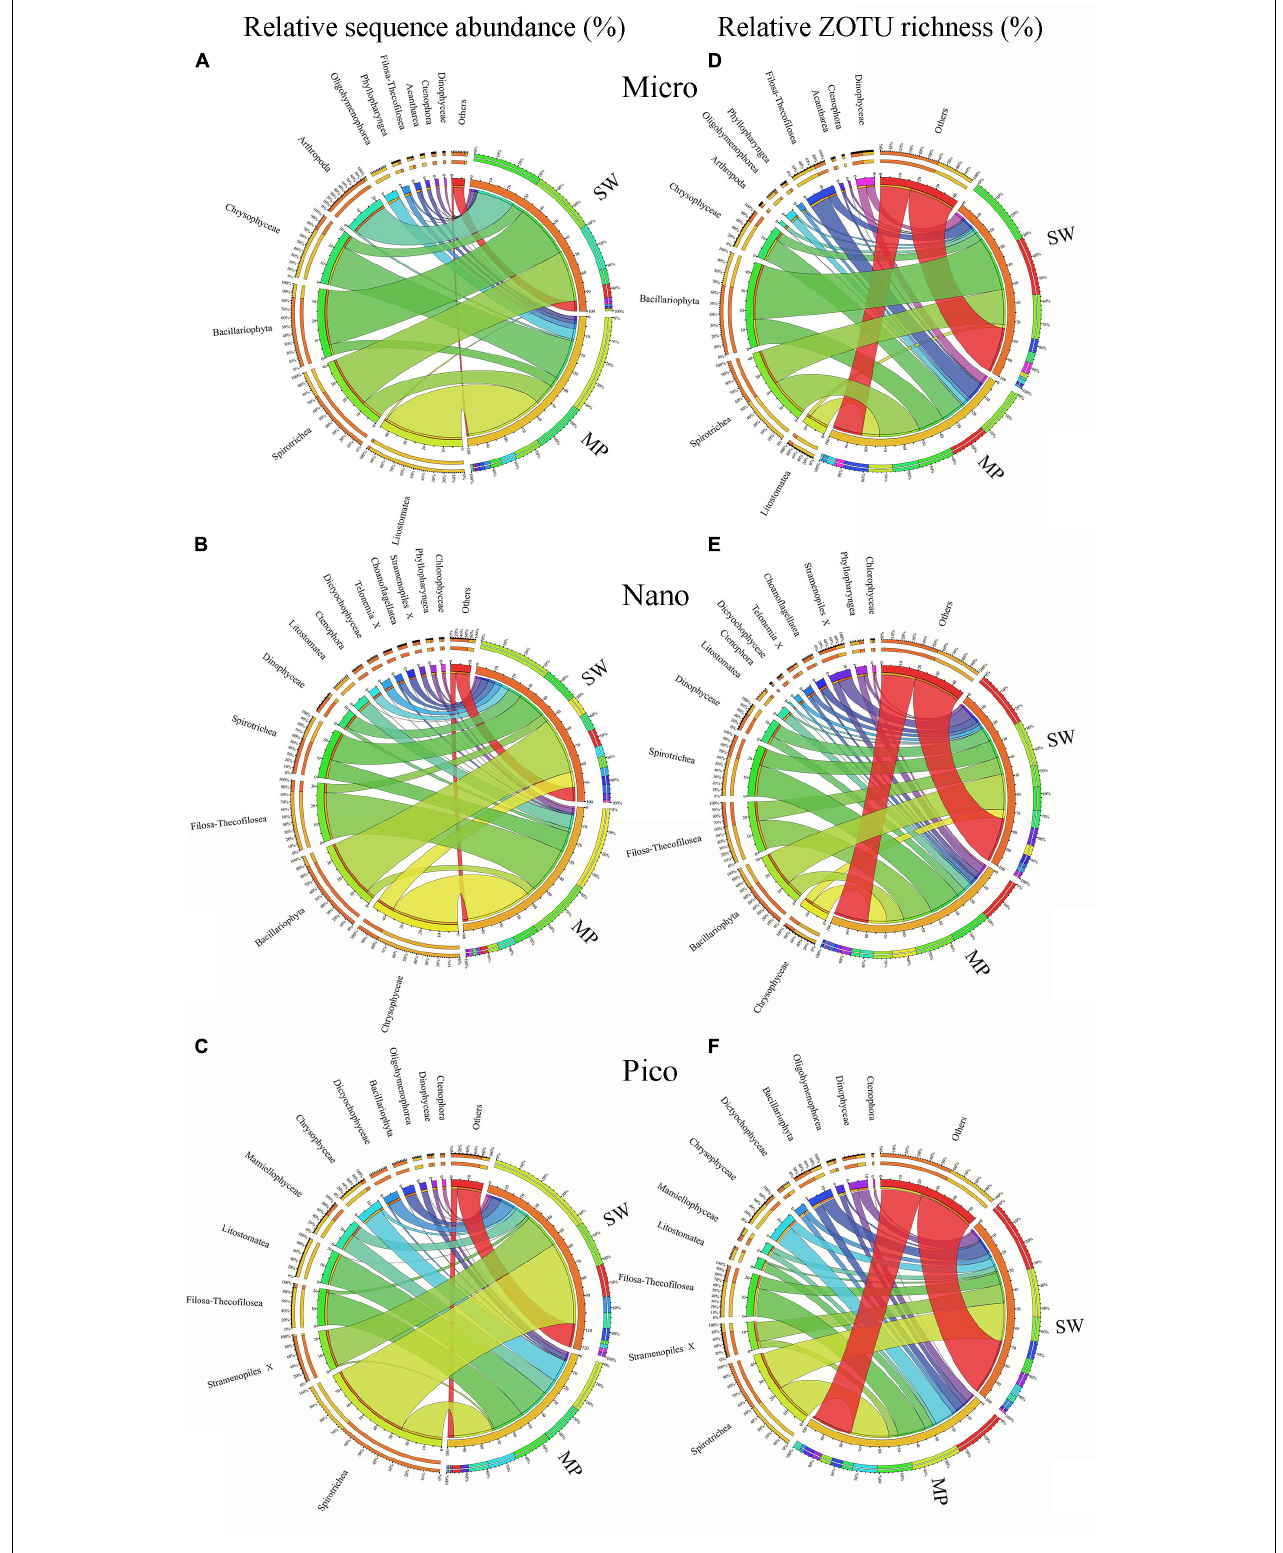
FIGURE 6 | Overview of size-fractionated microbial eukaryotes in the sea water (SW) and melt ponds (MPs). Relative sequence abundance and ZOTU richness of micro- (A,D) , nano- (B,E) , and pico-sized (C,F) microbial eukaryote subcommunities.